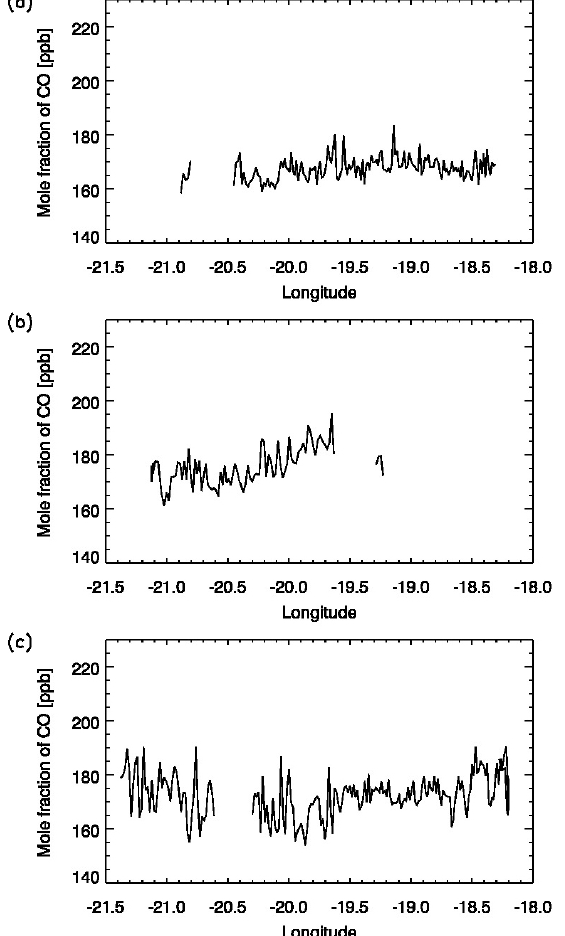
Fig. 7. Aircraft measurements of mole fraction of CO [ppb] from the AL5002 Carbon Monoxide instrument for (a) 400m height, (b) 700m height and (c) 1900m height. The values shown are 10 sec- ond averages.